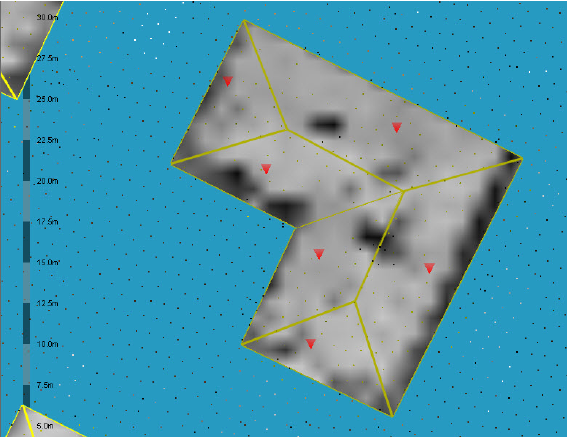
Figure 10: Building passed QA with little manual editing